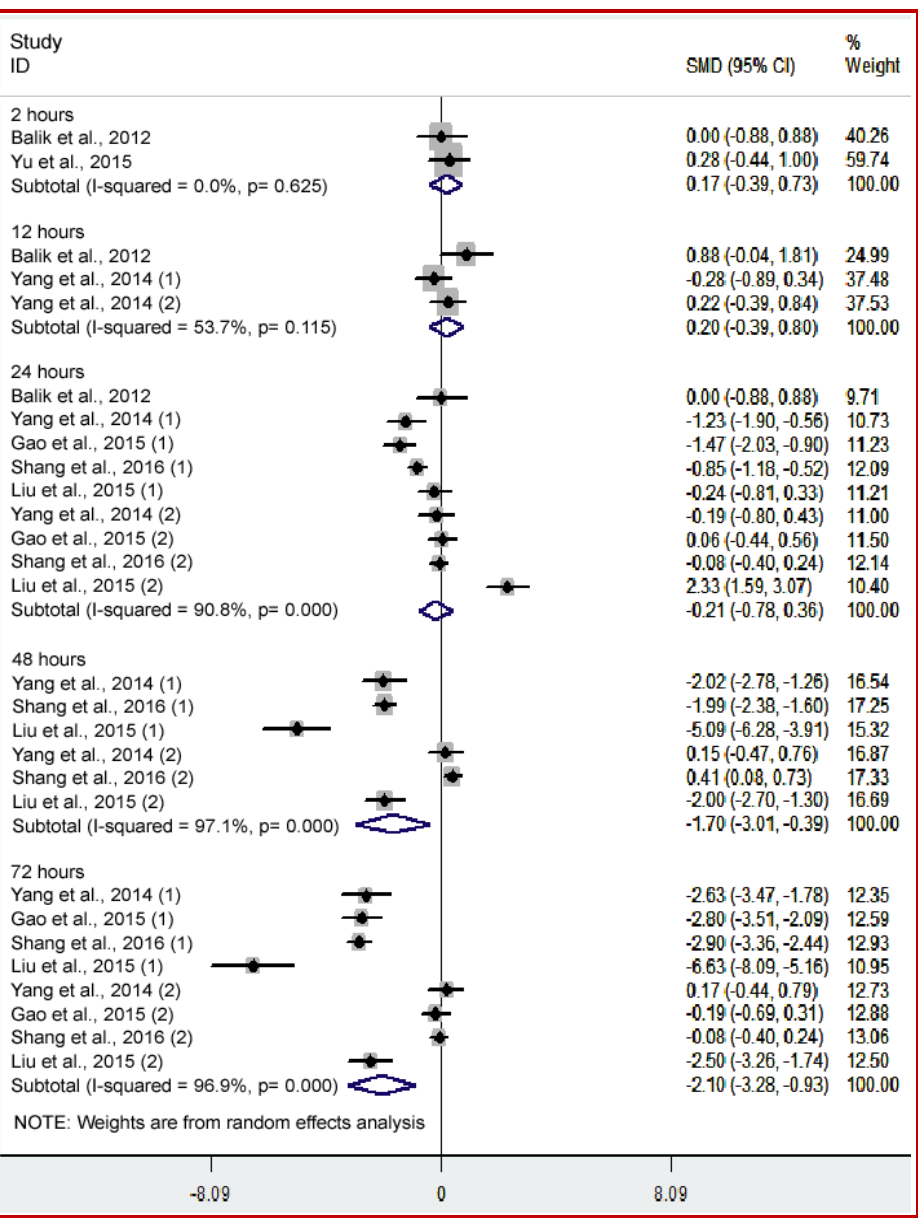
Figure 12: Meta-analysis of beta-blocker on the blood lactic acid (digit within the parenthesis means the number of studies for comparison) vascular hemodynamics in patients with peripheral arterial disease. J Clin Hypertens (Greenwich). 2016; 18: